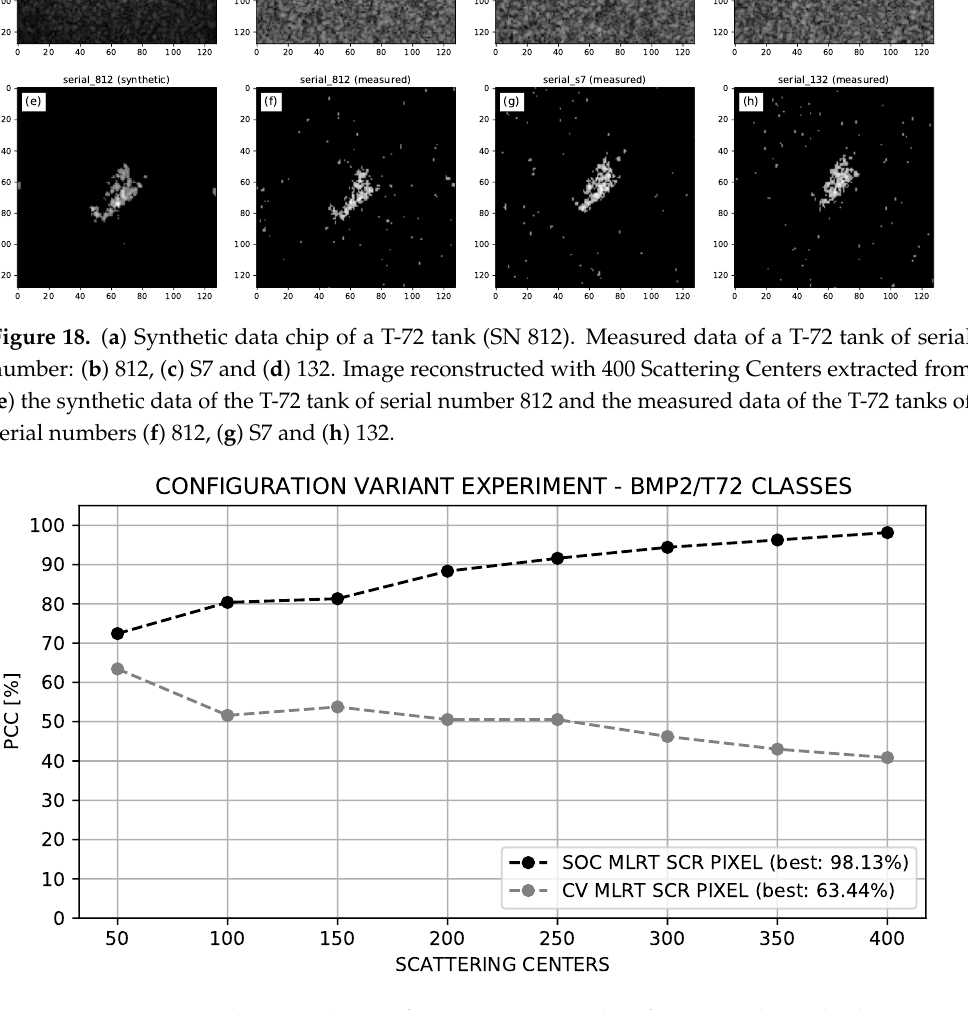
Figure 19. Comparison between the Configuration Variant classification and Standard Operating